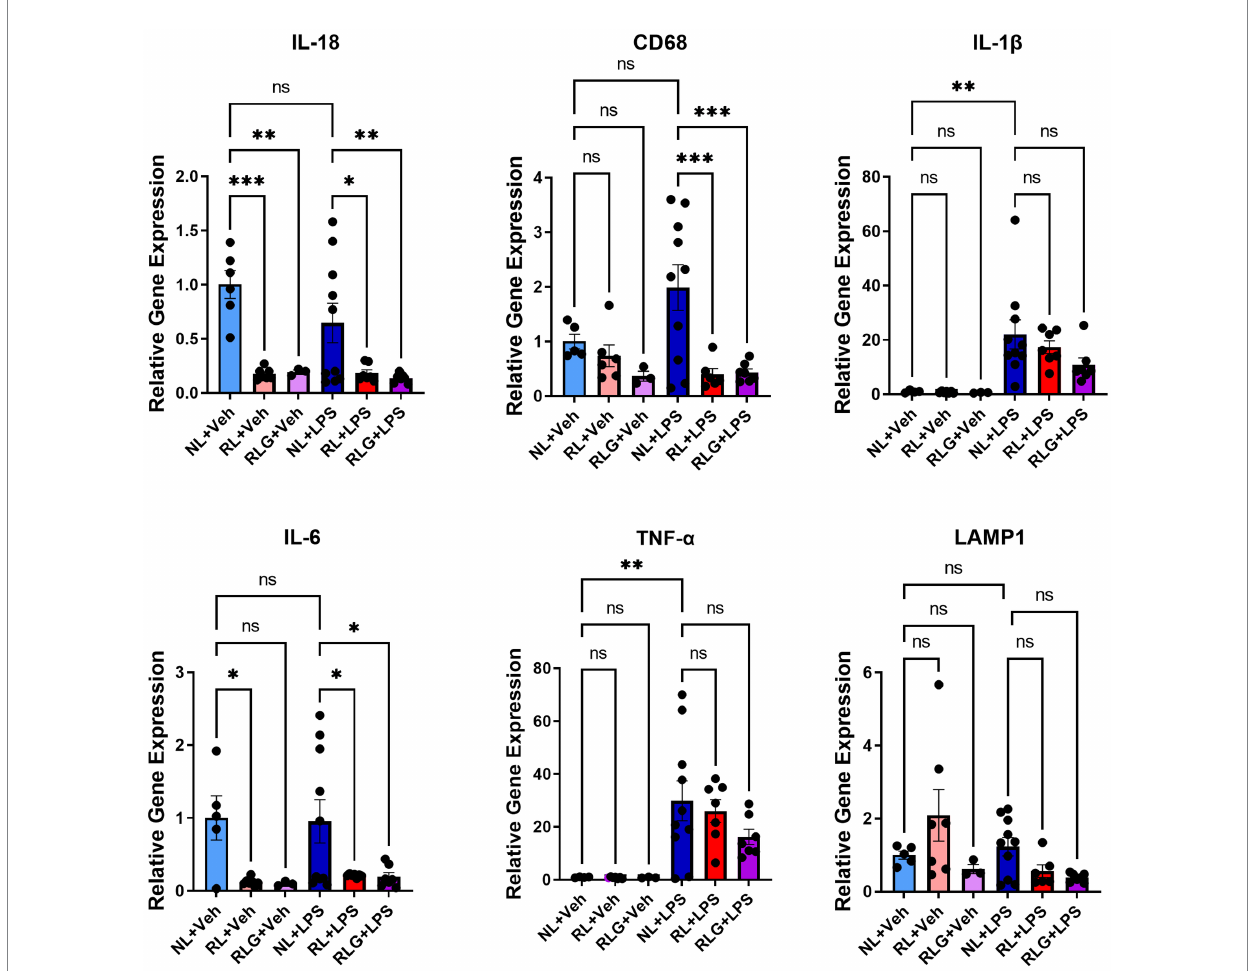
FIGURE 5 RT-qPCR analysis of select markers in hippocampus-containing brain tissue. There was significant downregulation of IL-18, CD68, and IL-6 in the RL + LPS and RLG + LPS groups, when compared to the NL + LPS group. In addition, when compared with the NL + Veh group, there was a significant downregulation of IL-18 in both the RL + Veh and the RLG + Veh groups, as well as a downregulation of IL-6 in the RL + Veh group. Upregulation of TNF- α and IL-1 β was consistent with an inflammatory response in the NL + LPS group, when compared to the NL + Veh group. Data are presented as mean ± SEM. * p < 0.05, ** p < 0.01, *** p < 0.001, **** p <